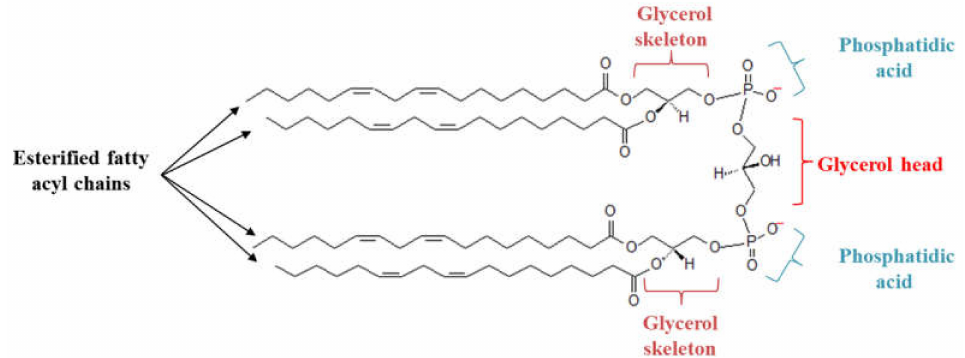
Figure 1. Structure of cardiolipin (CL). Each CL possesses a glycerol head group bound to two phosphatidyl moieties, forming an anionic polar head group. The presence of four esterified fatty acyl chains bound to the glycerol head group forms a cone-shaped